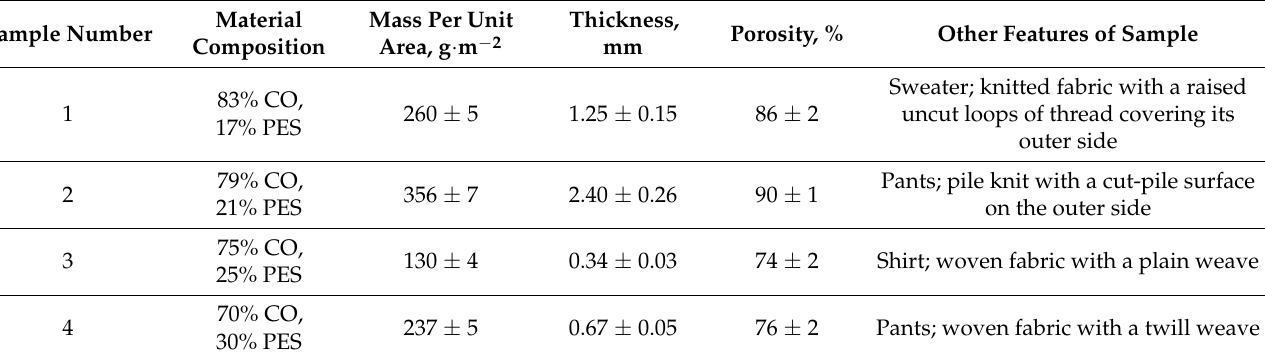
Table 1. Characteristic of examined textile